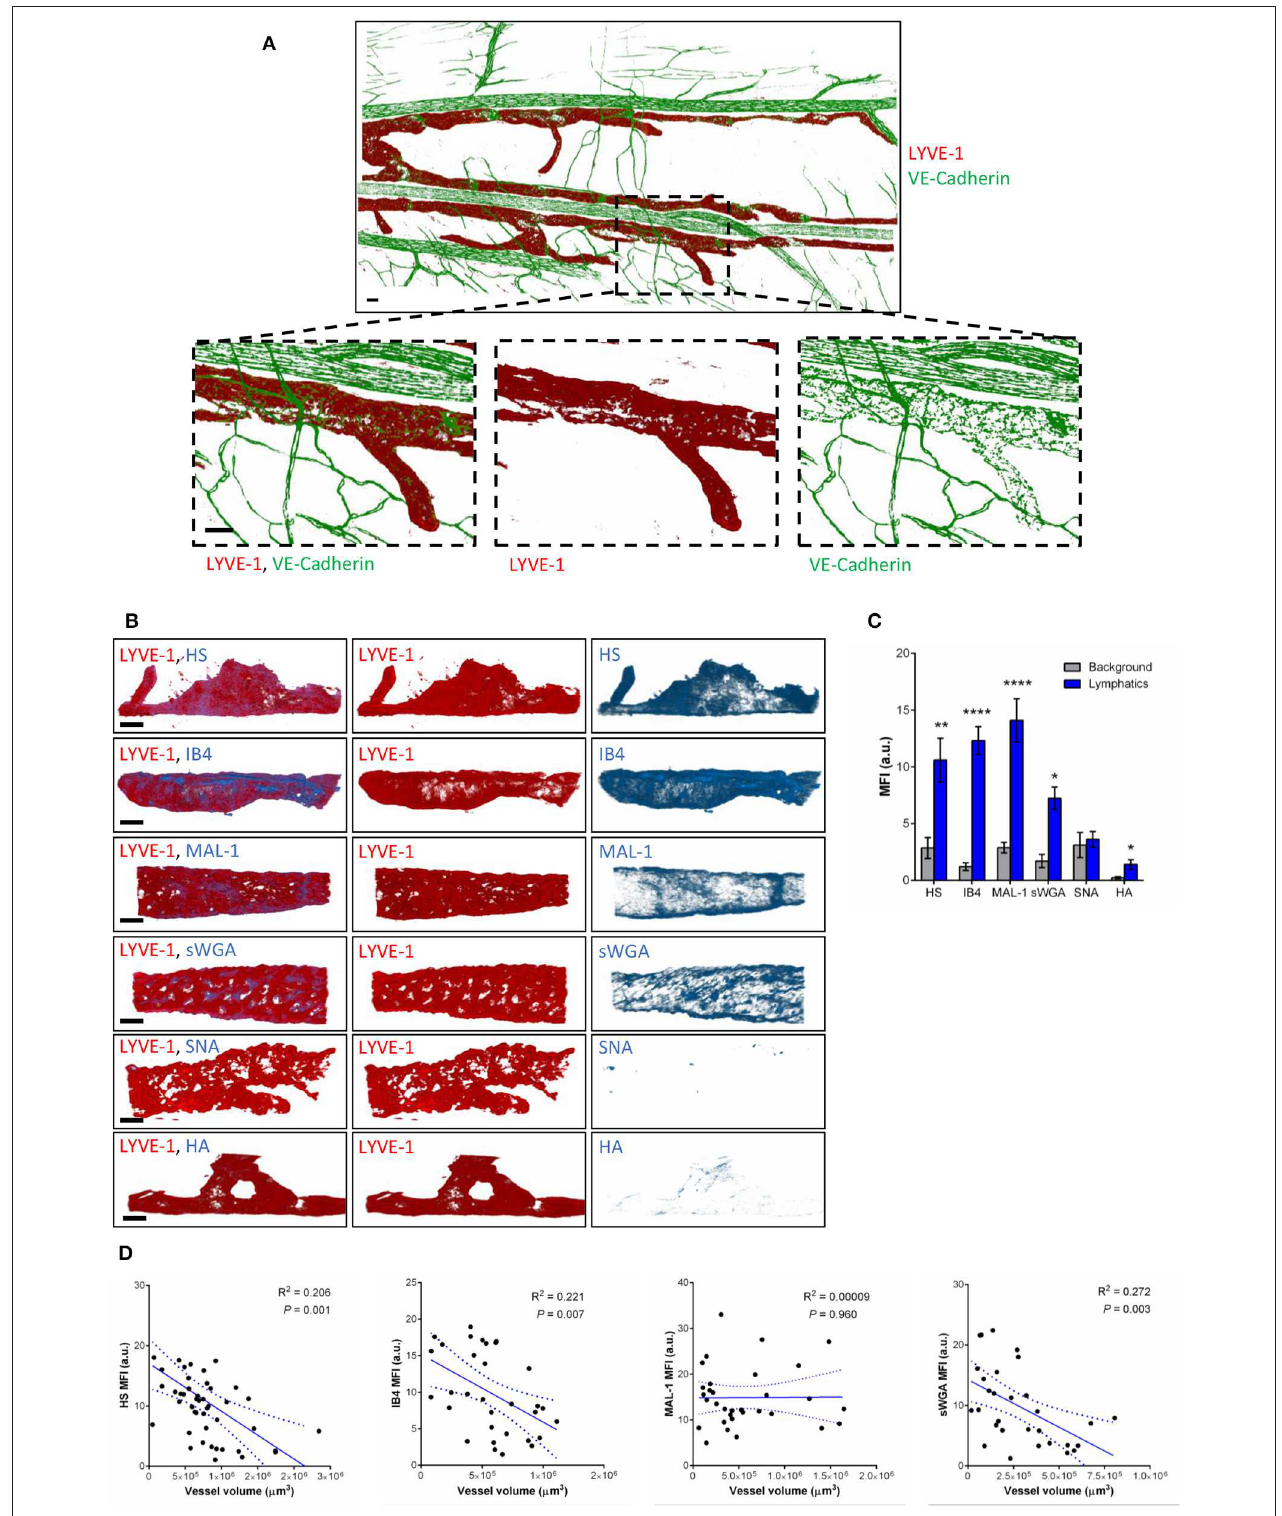
FIGURE 1 | Molecular composition of the glycocalyx on initial lymphatics of mouse cremaster muscles. (A) Representative 3D-reconstructed confocal tiled images showing the extent of the lymphatic vasculature (LYVE-1, red) in the cremaster muscles. Bottom panels are magnified images of a region within the tissue (dotted box)